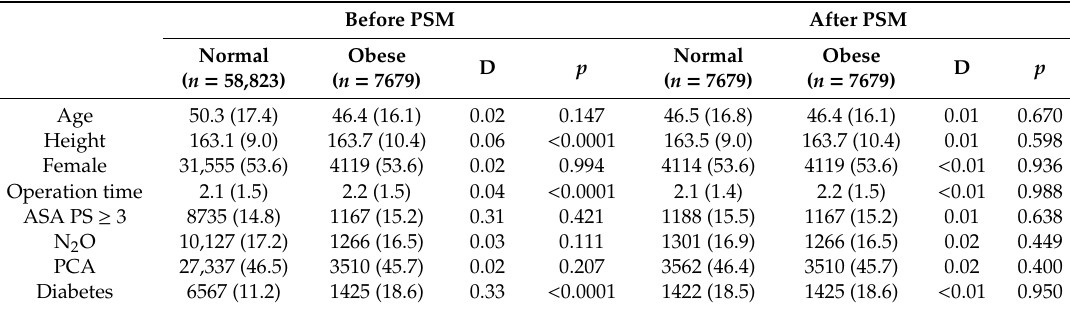
Table 5. Baseline characteristics of normal-BMI and obese subjects, and comparison before and after propensity score